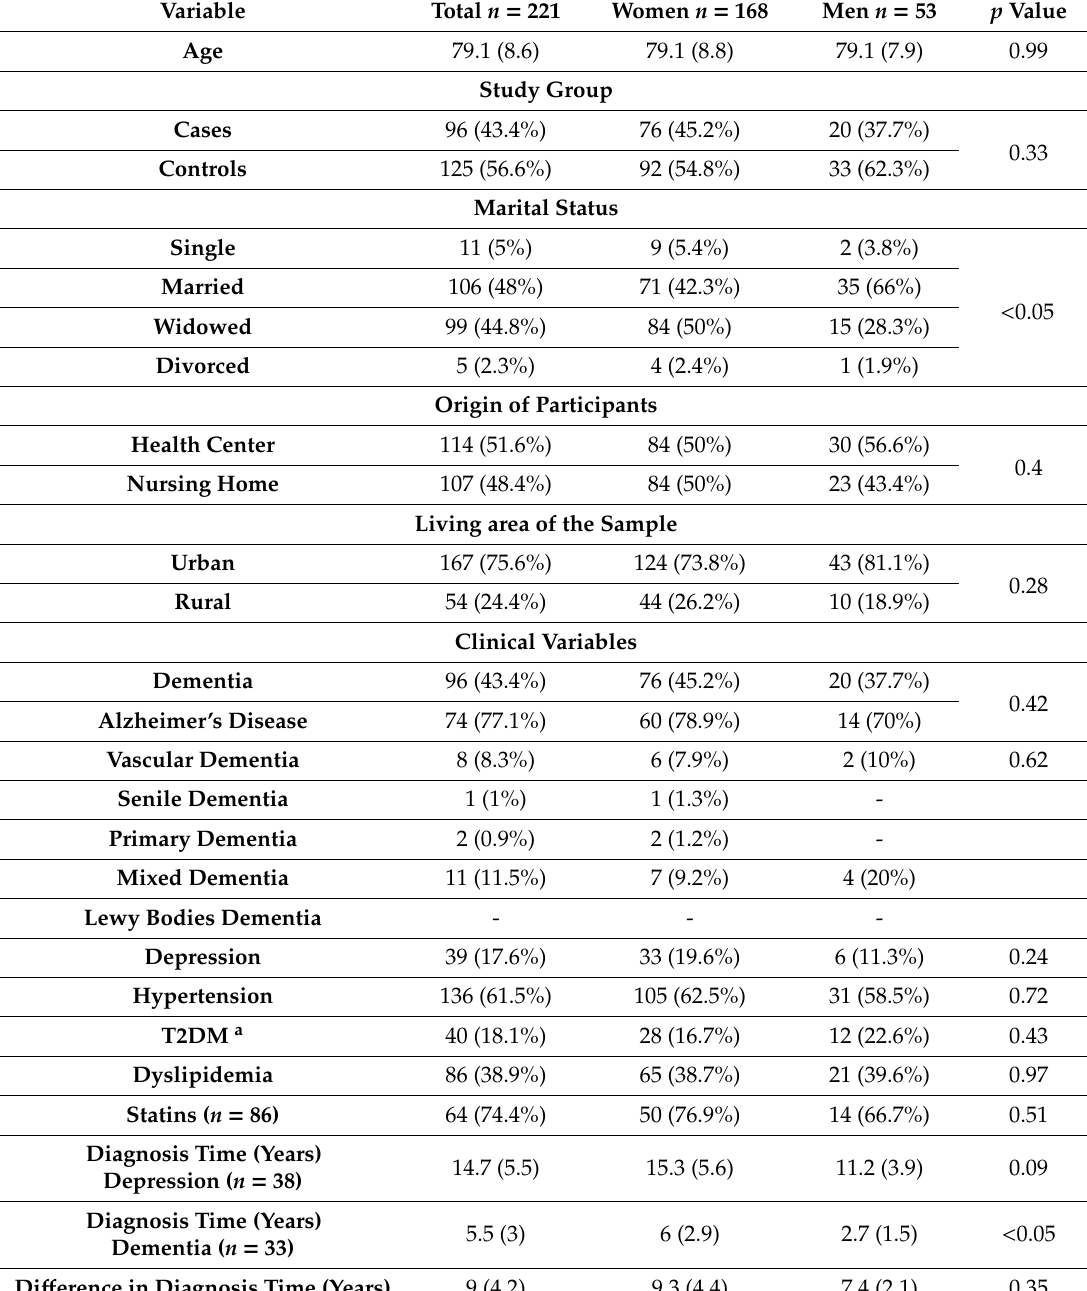
Table 1. Description of the sample according to